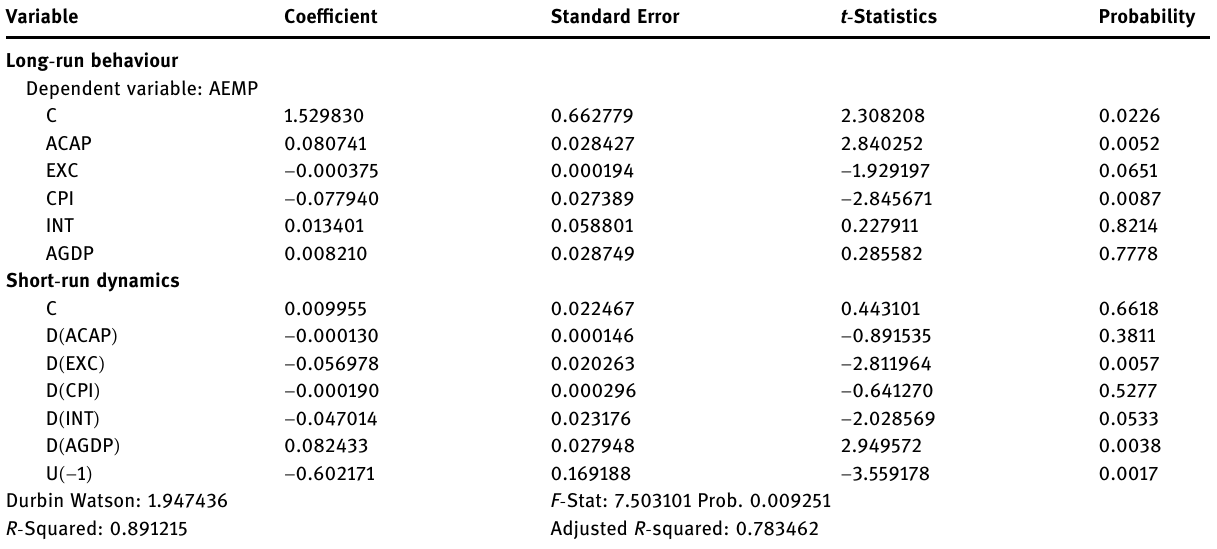
Table 4: Long - run and short - run dynamics for model 2